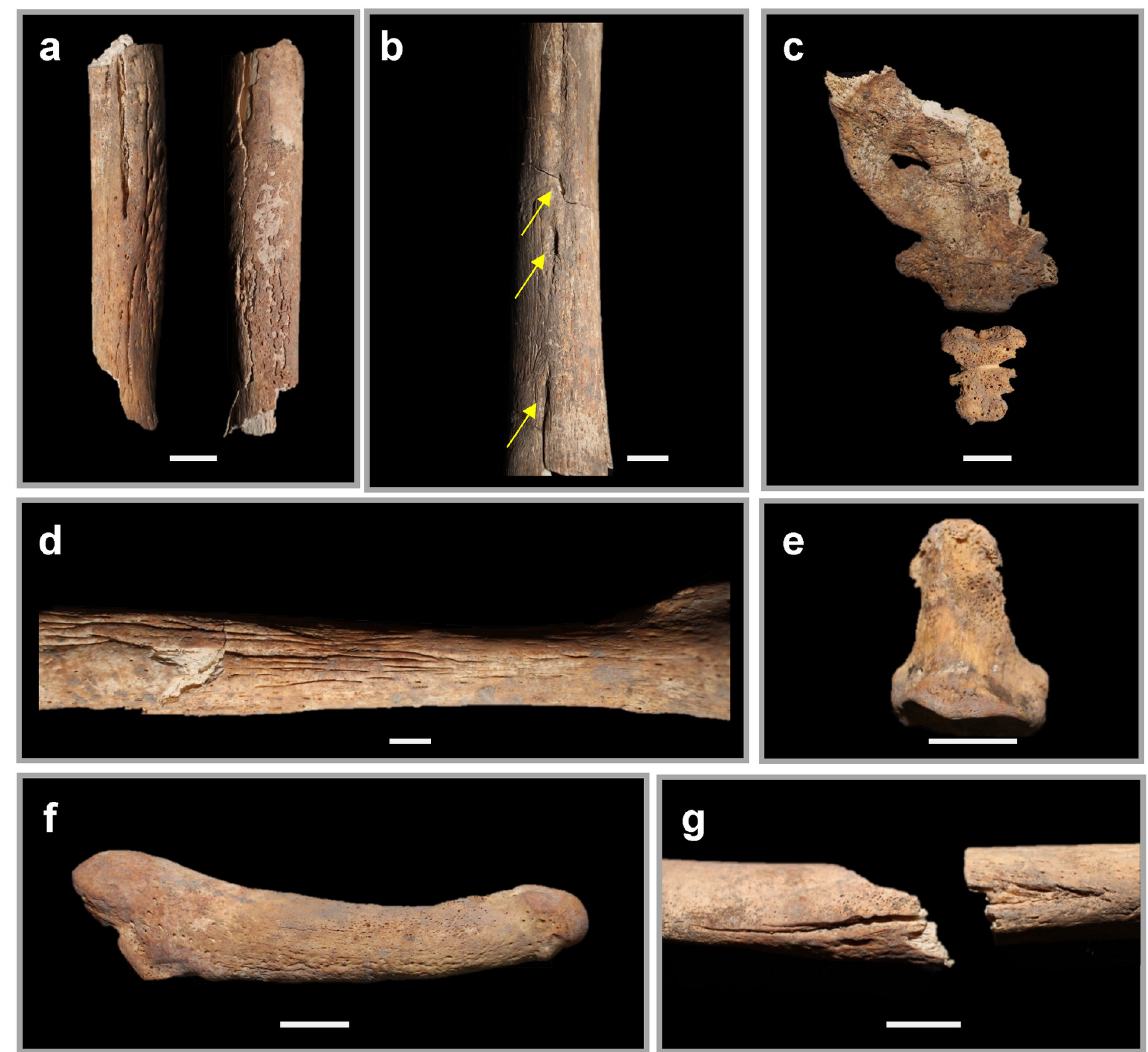
Fig 9. Selected skeletal elements from Individual 2 which show the extent and variety of the lesions. a: Right ulna at midshaft in anterior and posterior view, with cross-section in center, b: Right distal femur in posterior view with arrows pointing to sequestra, c: Sacrum and coccyx showing porosity, d: Unsided fibula showing reactive longitudinal periosteal lesions, e: Left distal foot phalanx, ray 1, in dorsal view, showing porosity f: Left fifth metatarsal in dorsal view, showing periosteal new bone growth, g: Left humerus at midshaft (broken postmortem), showing longitudinal fissures and periosteal new bone growth. All scale bars are